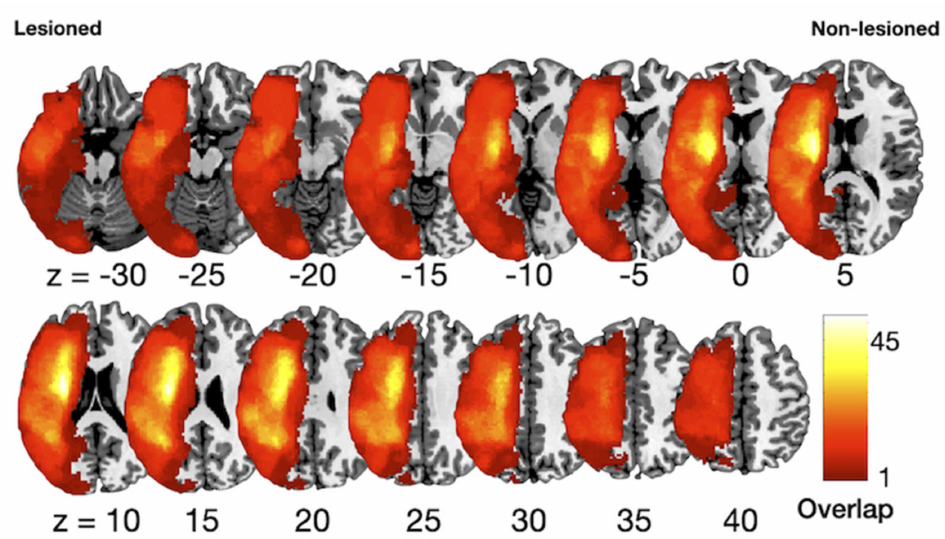
Figure 1. Lesion overlapping maps. A T1-weighted template was used to demarcate lesions for every patient. The color scale indicates the percentage of overlapping lesions across patients.